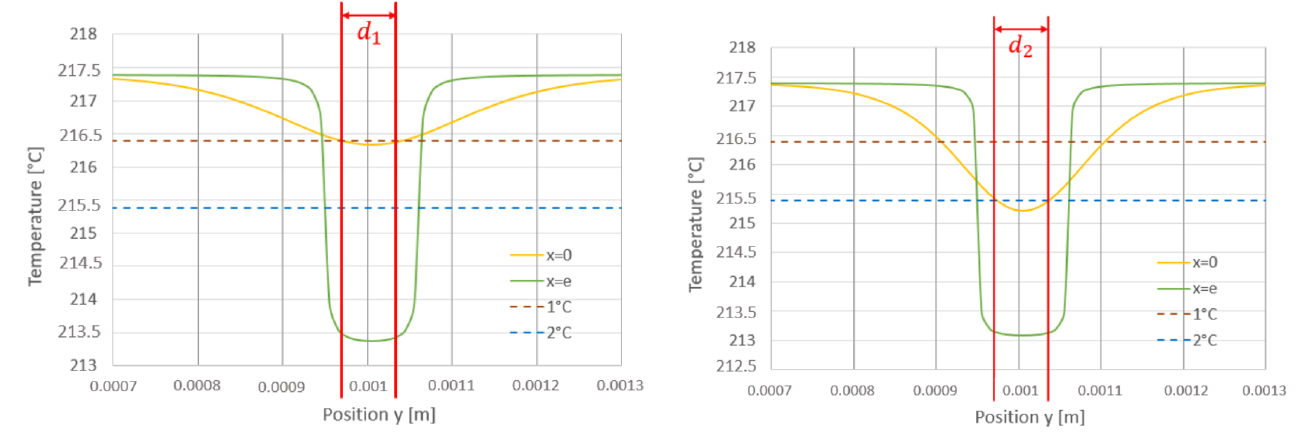
Figure 21. Example of the verification of the zone of influence of the temperature variation according to criteria 1 and 2. Here, for a pressure of 20 bar, for a thickness of 170 µm ( left ), criterion 1 is respected, the zone of influence is 60 µm; for the second criterion ( right ), it is necessary to reach 100 µm of thickness to detect the influence area on the dry side. This problem–solution was solved with the following values: N x = 50, N y = 200, n = 50, t g = 0.005s, t w = 0.01s, , ∆ t =